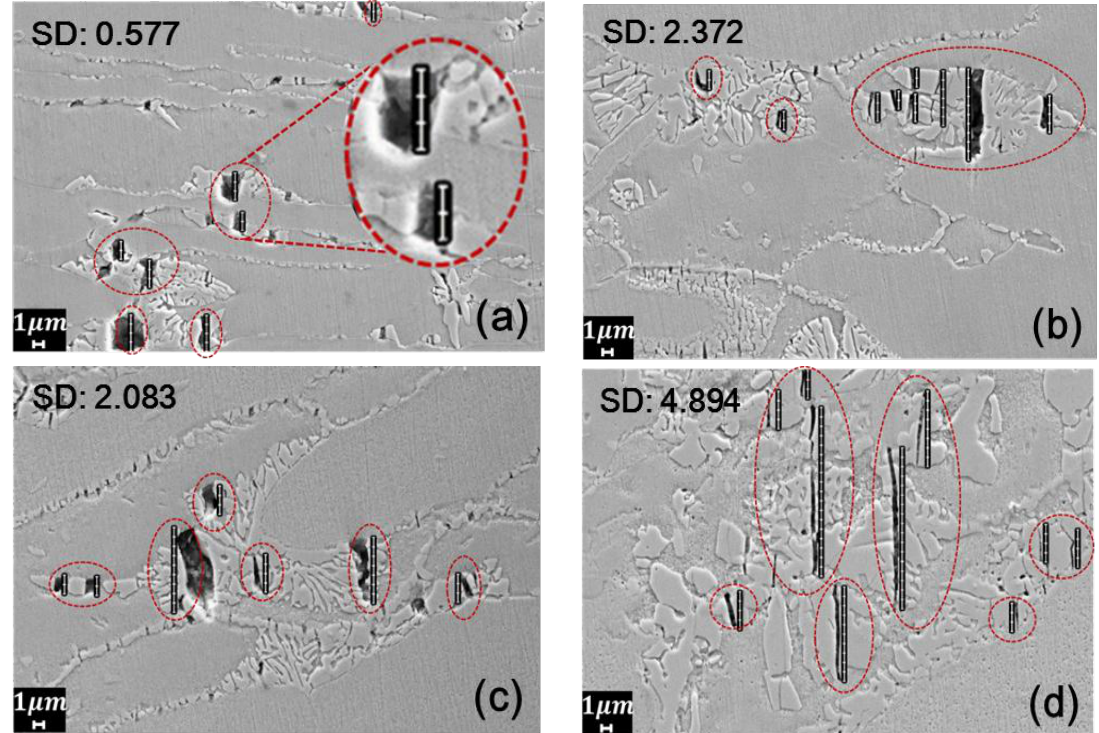
Figure 10. Measuring length of microcracks through the σ the phase caused by tensile test of the specimen annealed for ( a ) 5 min; ( b ) 10 min; ( c ) 15 min; and ( d ) 30 min.